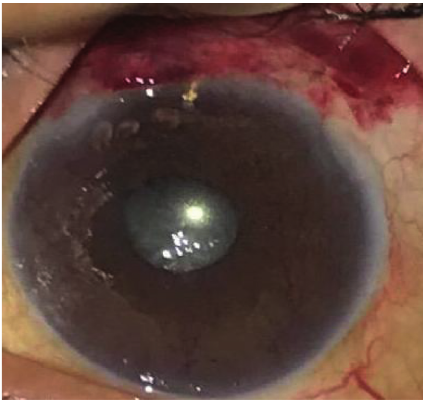
Figure 1: Express shunt after 1